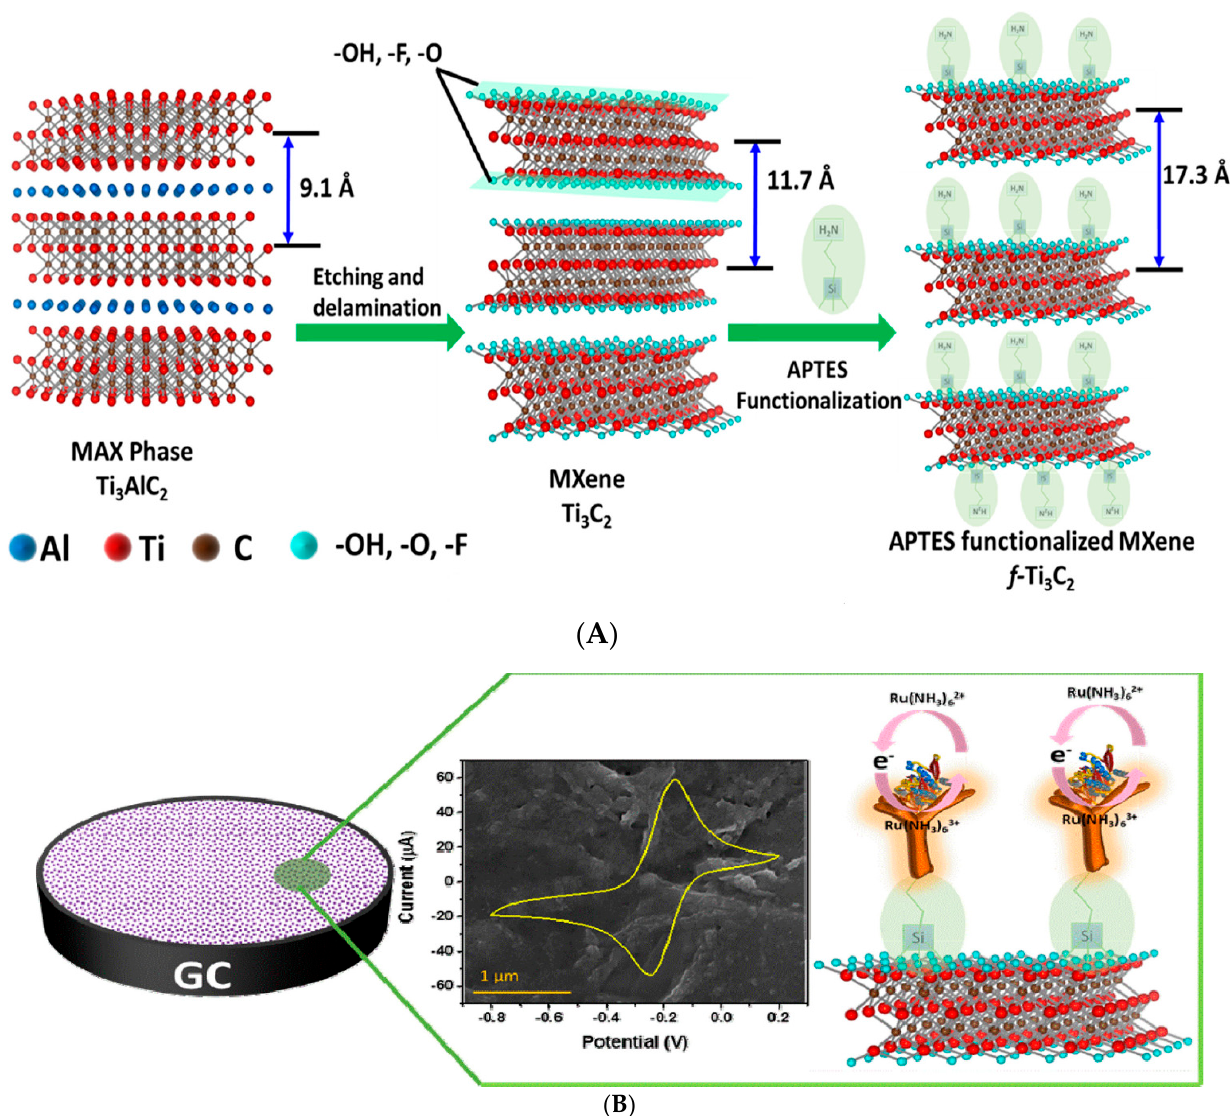
Figure 8. ( A ) Graphic model of Ti 3 C 2 -MXene functionalisation. Aluminum layer was etched from the Ti 3 AlC 2 -MAX phase, which delaminated into 2D nanosheets; the sheets composed of two layers of carbon intercalated within three tiers of titanium with the titanium surface arbitrarily surrounded with –OH, -O, and –F functional units. The Ti 3 C 2 -MXene surface was functionalised with APTES. Adapted from Ref. [112] with authorisation from Elsevier. ( B ) Design of the electrochemical CEA detection mechanism. Adapted from Ref. [112] with authorization from Elsevier.